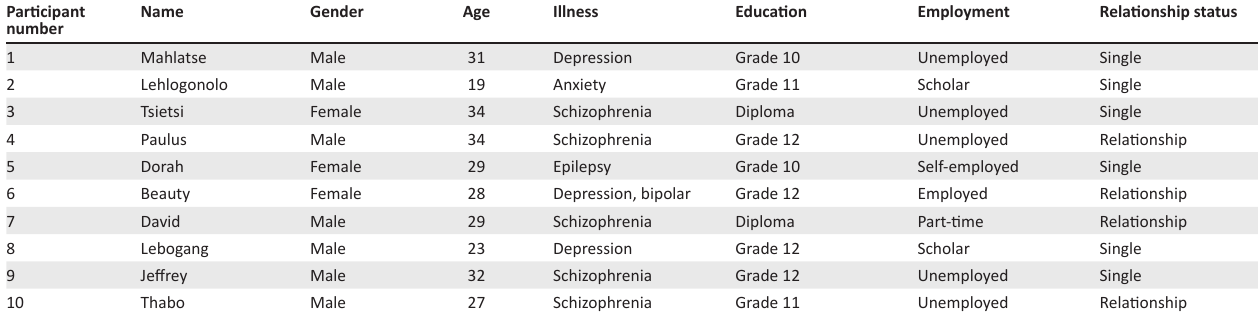
TABLE 1: Demographic information.